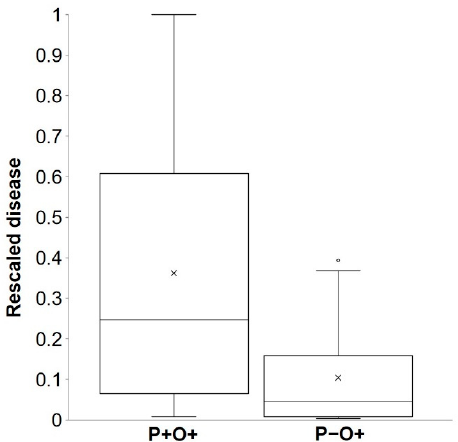
Figure 2. Box plot for rescaled primary infection values (i.e., rescaled relative to the maximum for